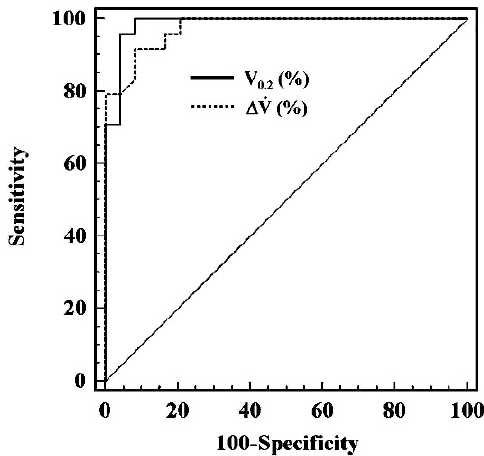
Figure 4 - Receiver-Operating Characteristic (ROC) curves of the measured upper airway collapsibility. The curves were evaluated as the expiratory volume at 0.2 s [V 0.2 ; the percent of the mean inspiratory volume of three breaths preceding NEP application (continuous line)] and as flow drop [ D _ VV ; the percent of the peak flow (dashed line)], which were induced by negative expiratory pressure for classifying normal subjects and patients with severe OSA (AHI